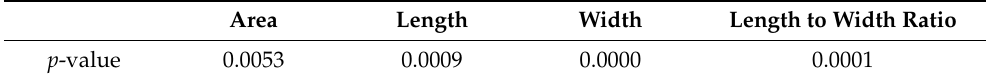
Table 6. Statistical comparison of basic geometry (size and shape) of hand-annotated RTS samples from the Eureka Sound Lowlands and Banks Island using independent Wilcoxson rank sum test.